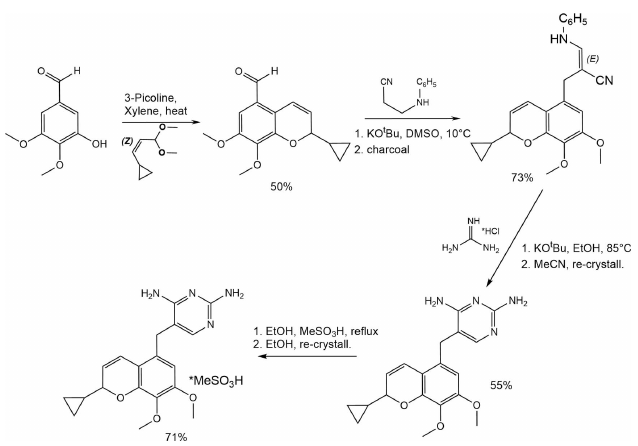
Figure 3 Synthesis scheme to prepare